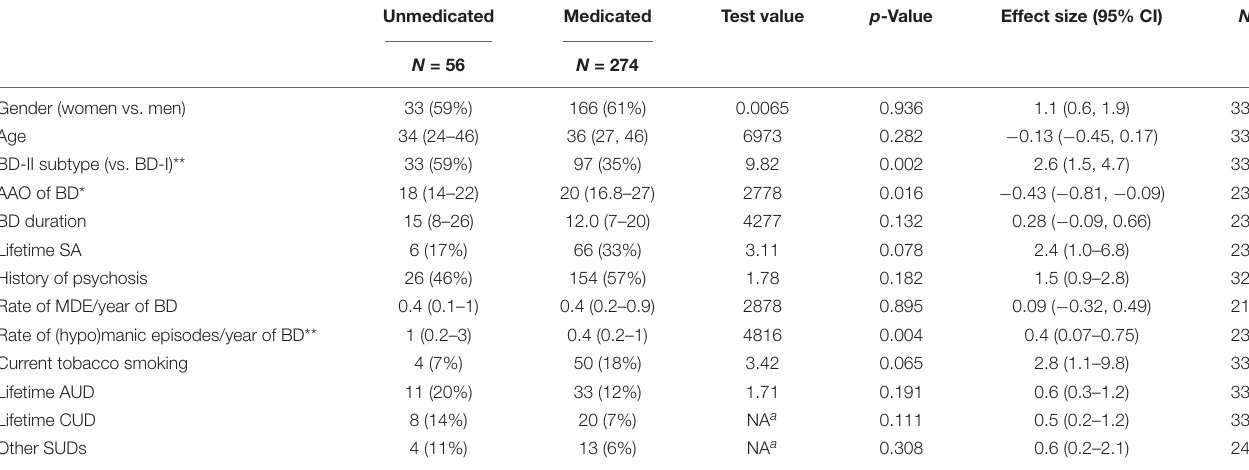
TABLE 3 | Variables associated with the current medicated status in the Norwegian subsample, who was not in their first mood episode. Unmedicated Medicated Test value p -Value